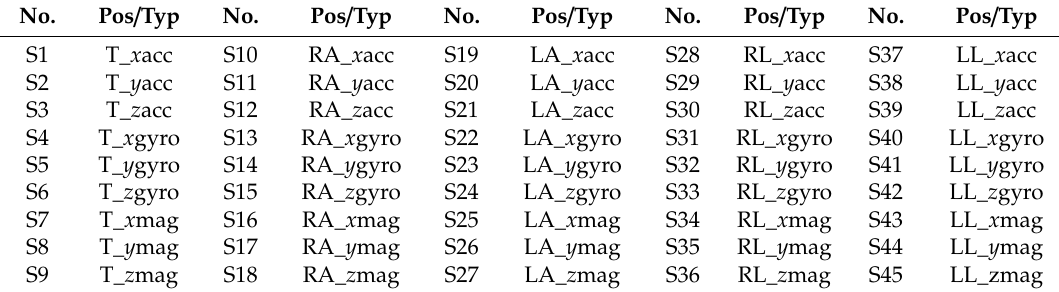
Table 2. The sensor types and their body positions in the daily and sports activities dataset (DSA).